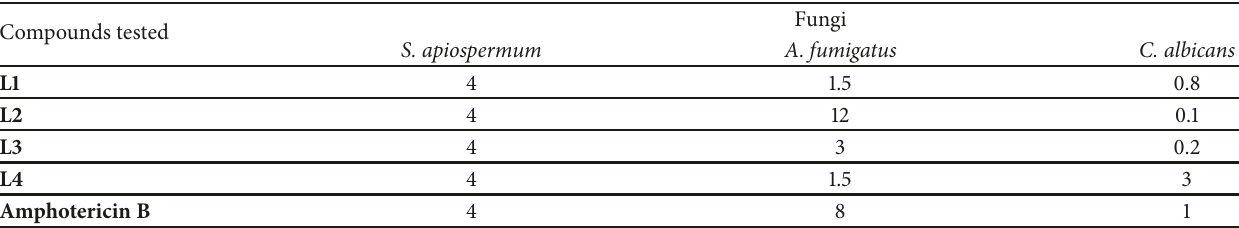
Table 2: Antifungal activities determined in liquid medium and expressed by a MIC 80 in 𝜇 g.mL −1 . Compounds